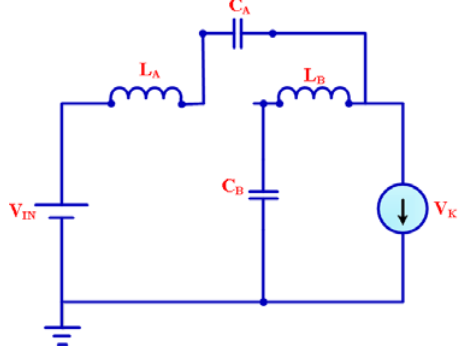
Figure 9. Equivalent model of Quasi Z ‐ source inverter in shoot through the state.